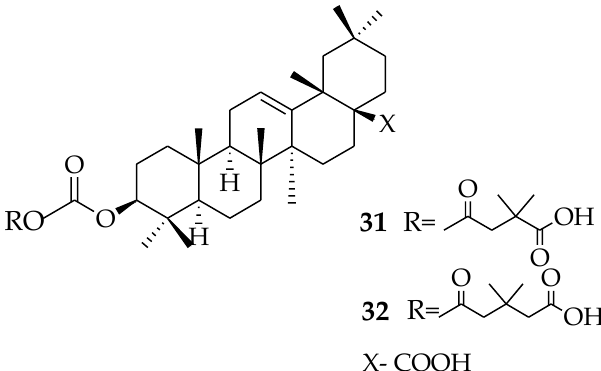
Figure 9. Previously modified anti-HIV triterpene derivatives.